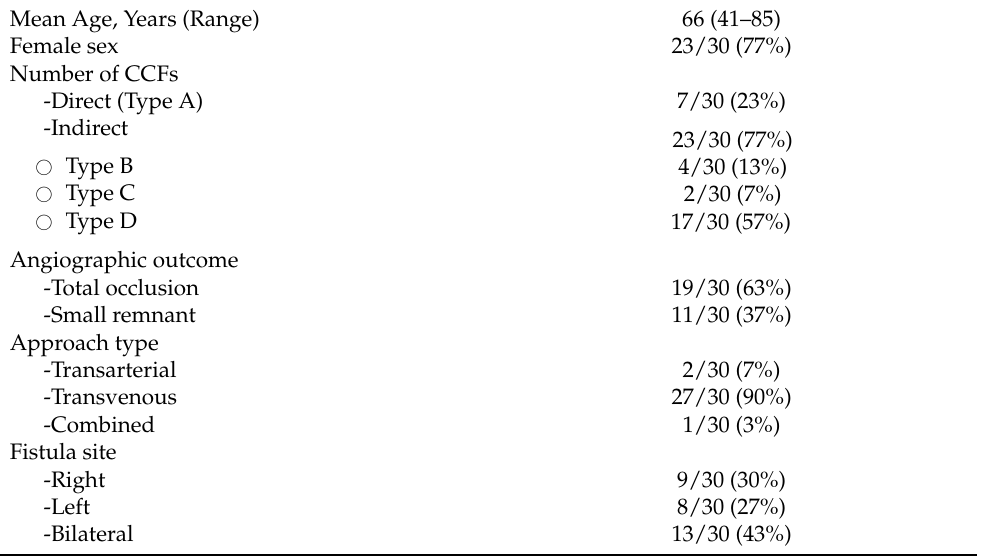
Table 1. Patient demographics and procedural data.